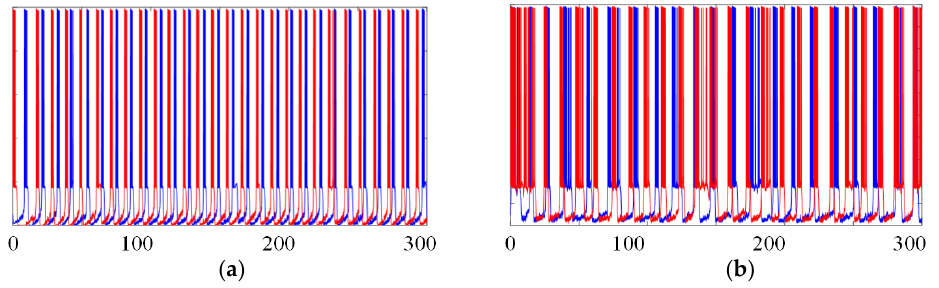
Figure 5. ( a ) The membrane potentials of the BiSRP-CPG network; ( b ) The membrane potentials of the original CPG network without astrocytes. Both neurons suffered a synaptic fault density of 20%.